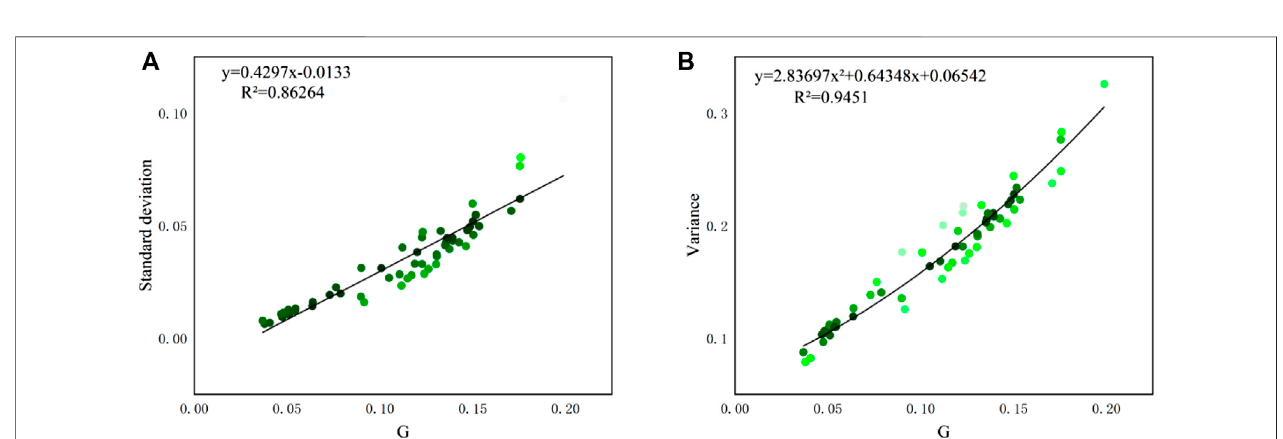
FIGURE 14 | Relationships between (A) . G ~ variance and (B) . G ~ standard deviation of spatial distribution (sample size: 61).